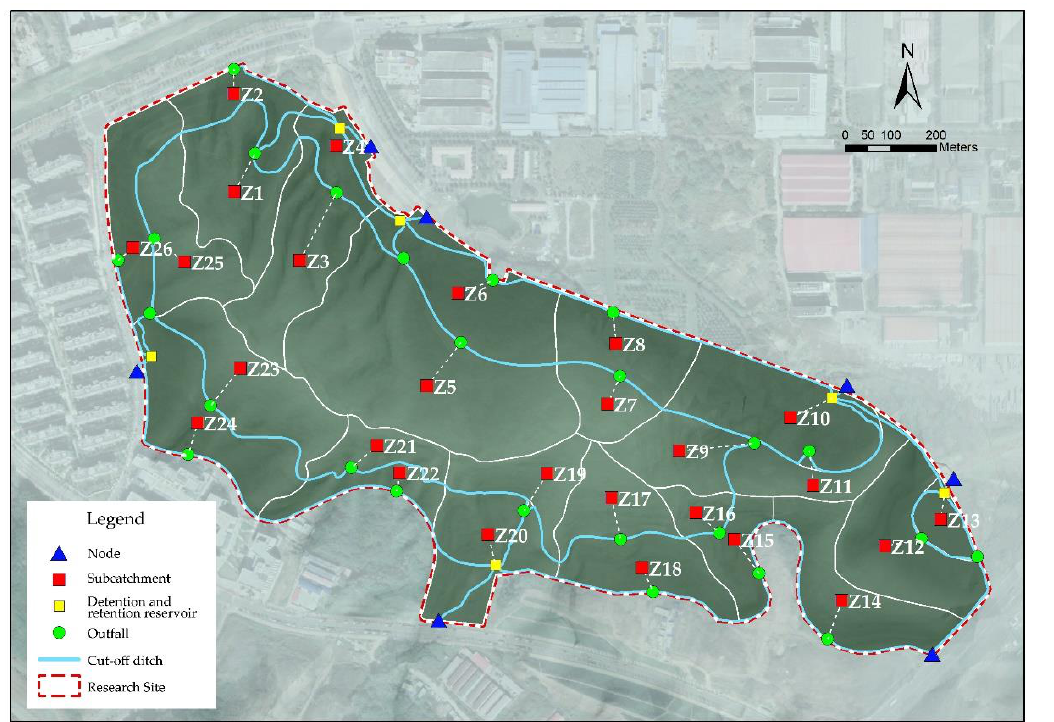
Figure 8. Division of Scheme T’s sub -catchments and layout of detention and retention wetlands.